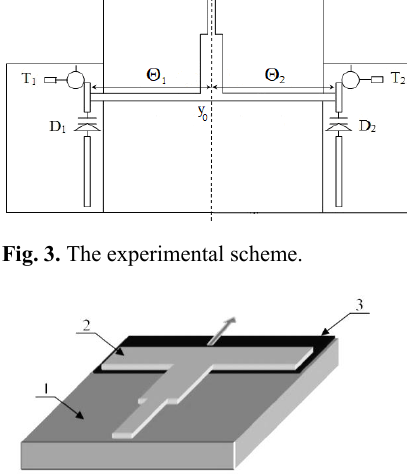
Fig. 4. Scheme introducing of losses into coupling channel; 1 – metal base, 2 – strip line sections, 3 – thin absorbent